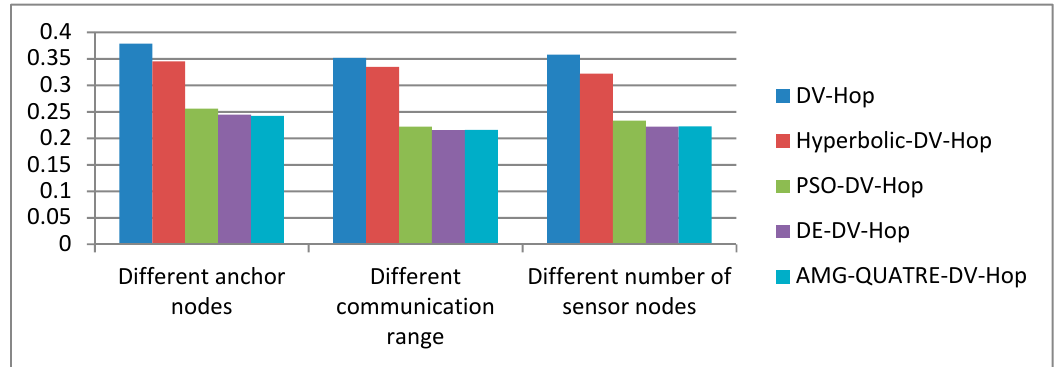
Figure 13. Comparison of average localization error of the applied AMG-QUATRE with the other methods.